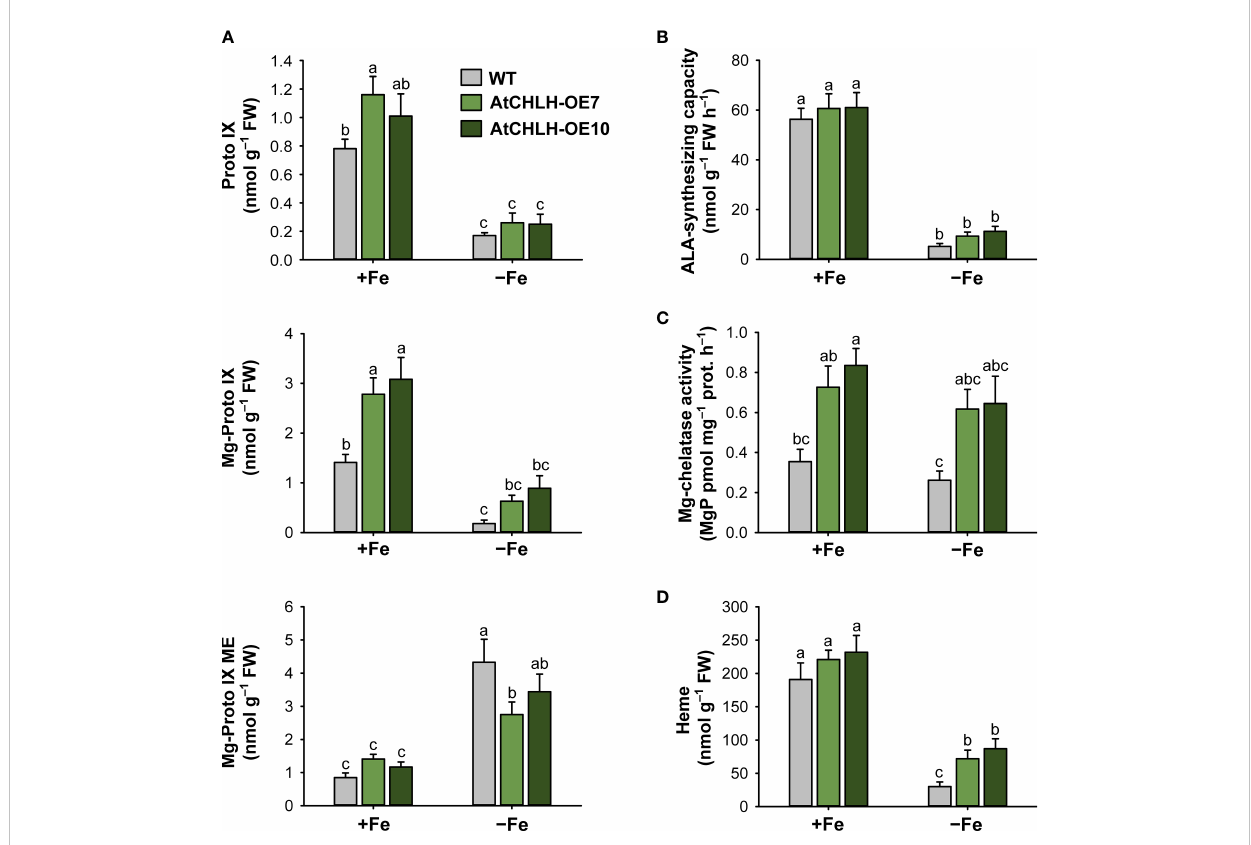
FIGURE 3 Effects of Fe de fi ciency on metabolic intermediates of the porphyrin biosynthetic pathway in leaves of WT and transgenic plants. (A) Proto IX and Mg- porphyrin intermediates. (B) ALA-synthesizing capacity. (C) Mg-chelatase activity. (D) Heme. WT and transgenic rice seedlings were transferred to half- strength Hoagland solution without or with 50µM Fe-EDTA for 7 days. AtCHLH-OE7 and AtCHLH-OE10, transgenic lines overexpressing AtCHLH ; +Fe, half-strength Hoagland solution with 50µM Fe-EDTA; – Fe, half-strength Hoagland solution with no Fe-EDTA. Values are means ± SE, and data from three independent experiments are presented. Different letters indicate signi fi cant differences at P < 0.05 by Duncan ’ s multiple range